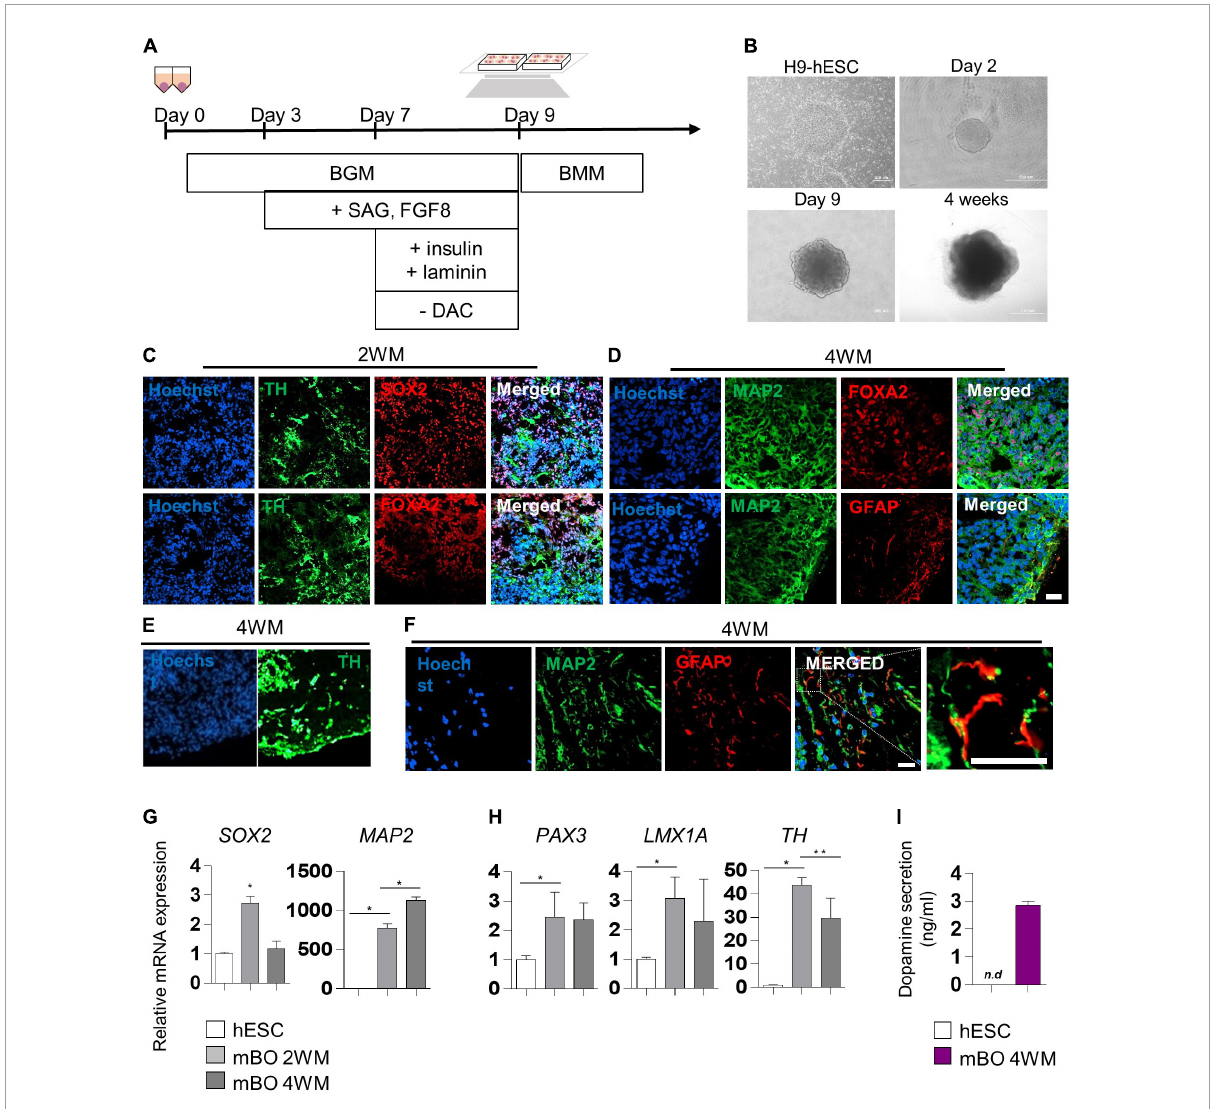
FIGURE1 Characterization of midbrain organoids. (A) Schematic method of the midbrain organoids generation. (B) Representative phase-contrast images of human embryonic stem cell (hESC) and midbrain organoids at day 2, day 9, and 4 weeks of maturation. (C–E) Representative Immunostaining fluorescence (IF) Images showing the expression of the differentiation markers ( SOX2, FOXA2, TH, MAP2, and GFAP ) in midbrain organoids after 2, 4 weeks of maturation. Hoechst was used for counter nuclei staining. (F) High-resolution images of MAP2 and GFAP in midbrain organoids. (G,H) The relative mRNA expression level of differentiation markers ( SOX2, PAX3, LMX1a, TH, and MAP2 ) of undifferentiated hESC and midbrain organoids (2WM, 4WM). (I) Quantification of dopamine secretion to conditioned media from undifferentiated hESC and midbrain organoids (4WMs). Data are AVE ± SD [ P < 0.05(*), P < 0.01(**)]. (Scale bar = 20 µ